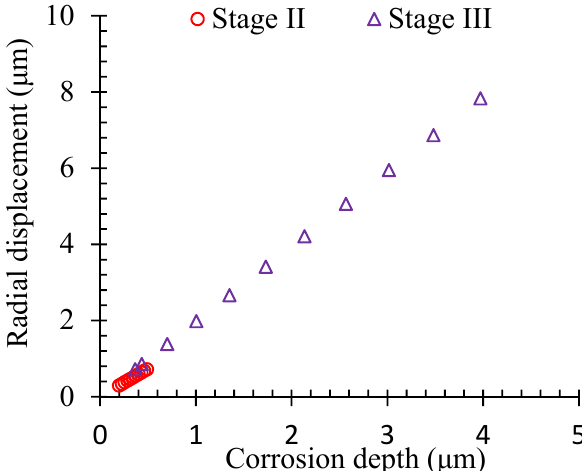
Figure 11. Displacement of the concrete at the steel-concrete interface.